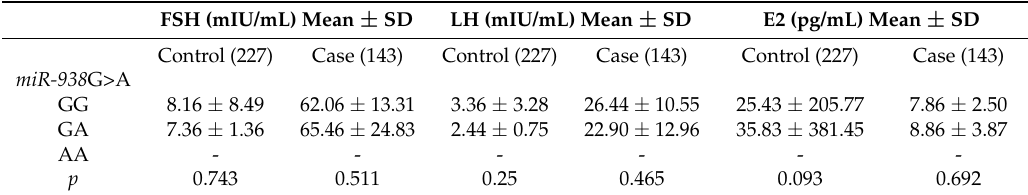
Table 2. FSH, LH and E2 levels in control subjects and POI patients with different miRNA polymorphic